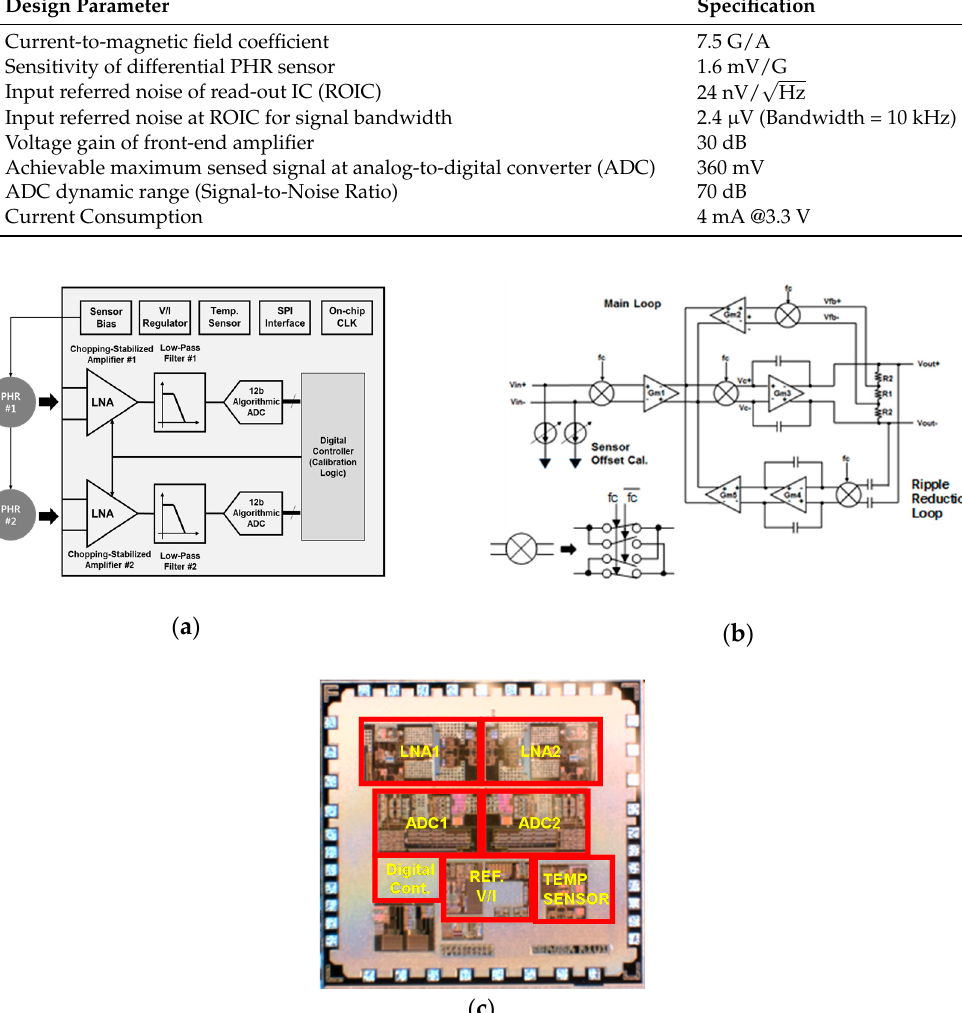
Figure 6. ( a ) A block diagram of the ROIC, ( b ) a schematic of the front chopping-stabilized amplifier of the ROIC, and ( c ) the fabricated chip microphotograph.